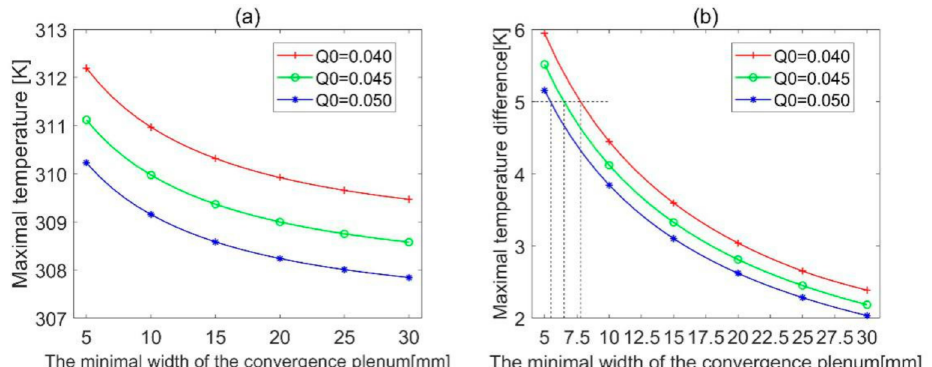
Figure 12. The influence of the minimal width of the convergence plenum on the temperature distribution for various inlet airflow rates. ( a ) effect on maximal temperature. ( b ) effect on maximal temperature difference. ( θ dp = 15 ◦ , θ cp = 15 ◦ , d 0 = 1 mm, w dp = 5